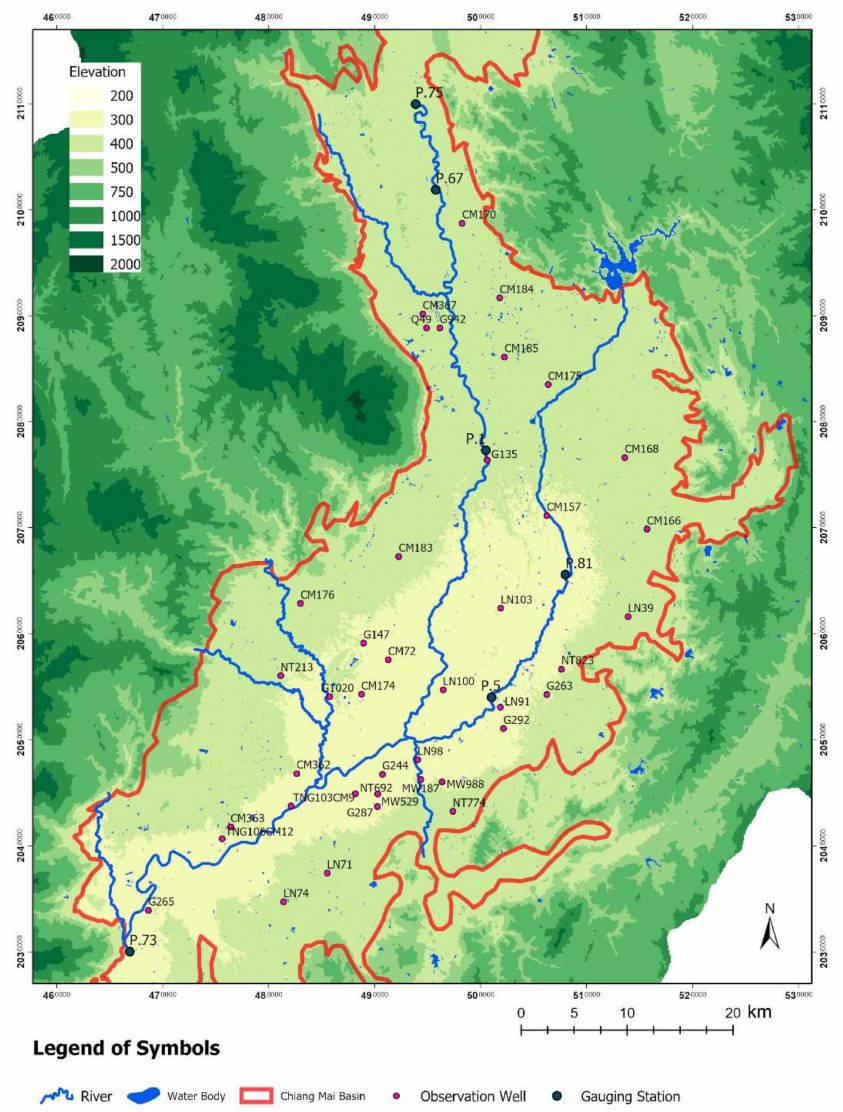
Figure 5. Locations of groundwater monitoring wells and gaging stations of basin’s main